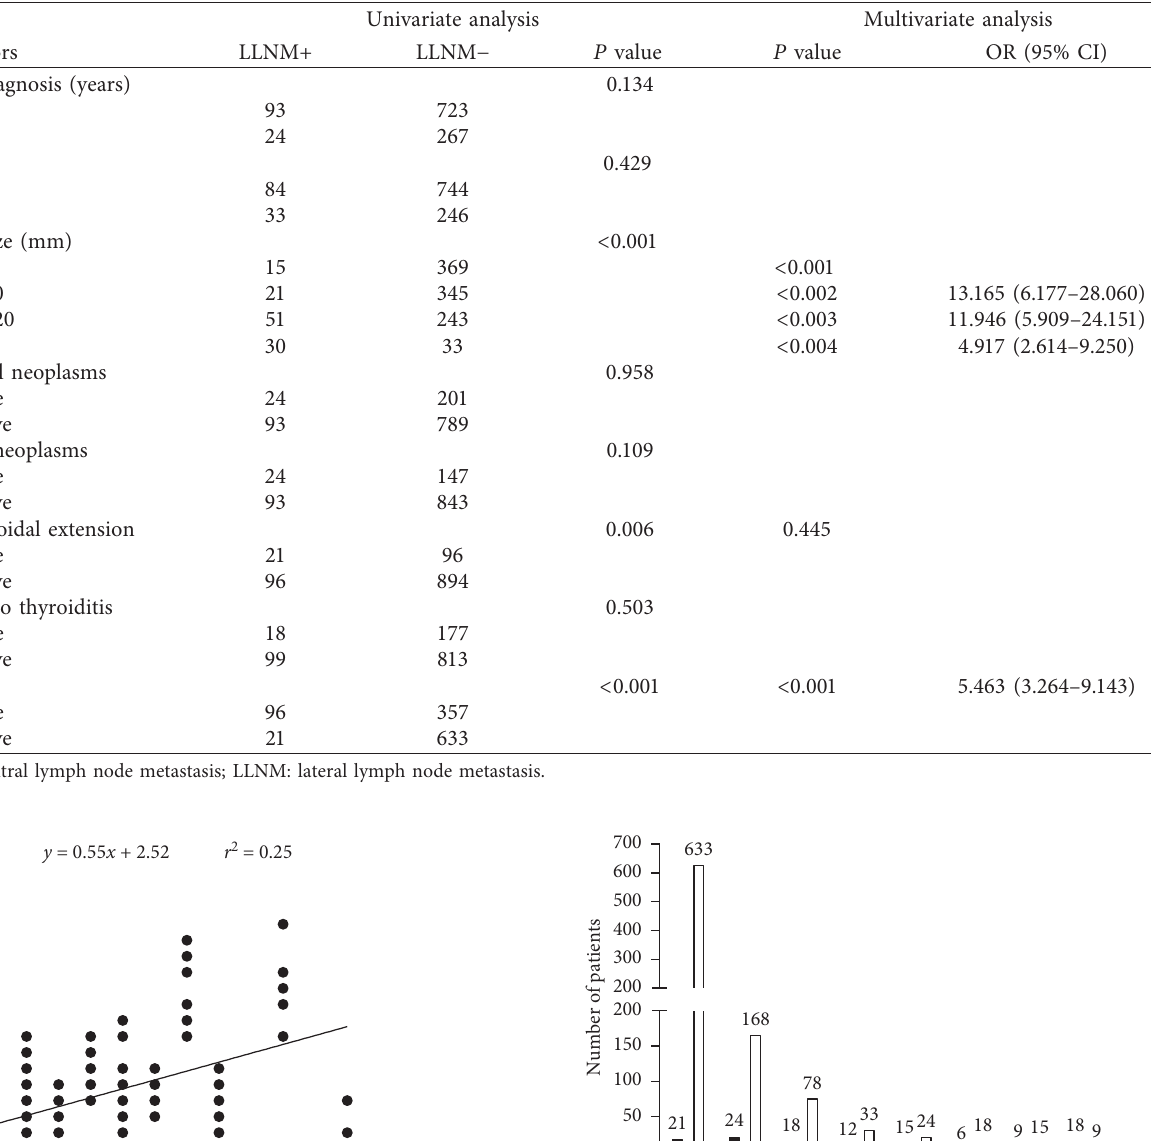
Table 5: Univariable and multivariate analysis for LLNM.